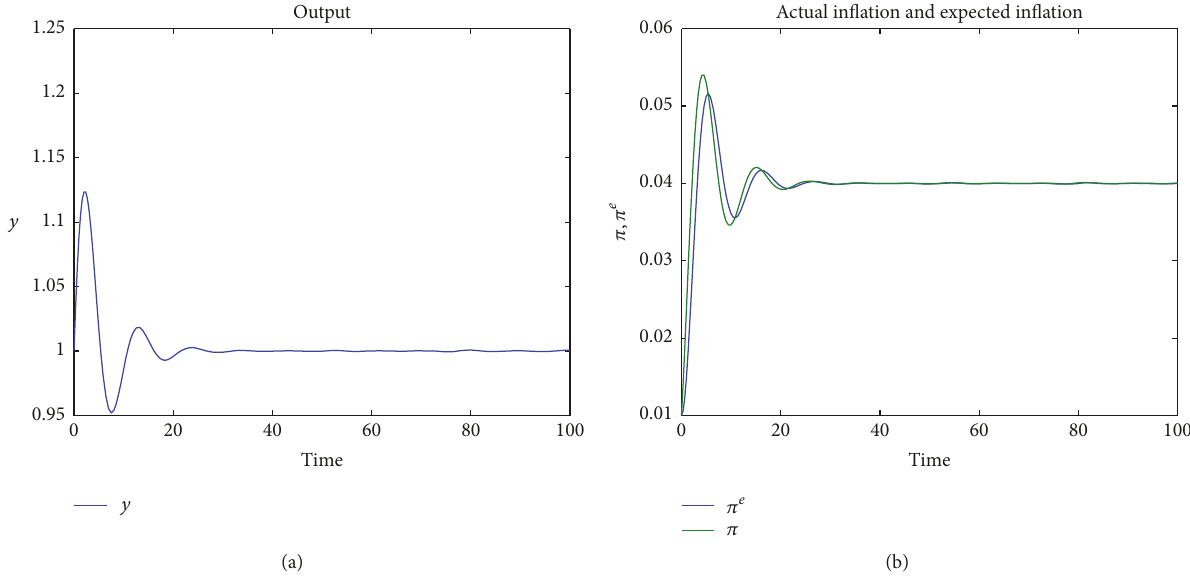
Figure 11: Monetary policy shock. (a) Solution for 𝑦(𝑡) . (b) Solutions for 𝜋(𝑡) and 𝜋 𝑒 (𝑡) .